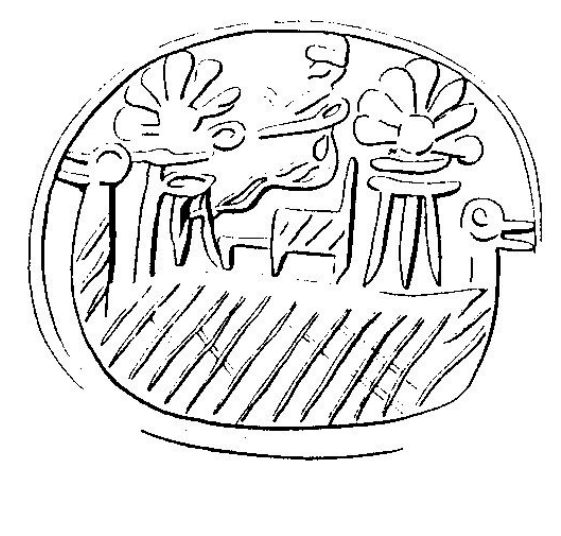
Figure 10 Seal of Elishama (Jerusalem, Iron Age